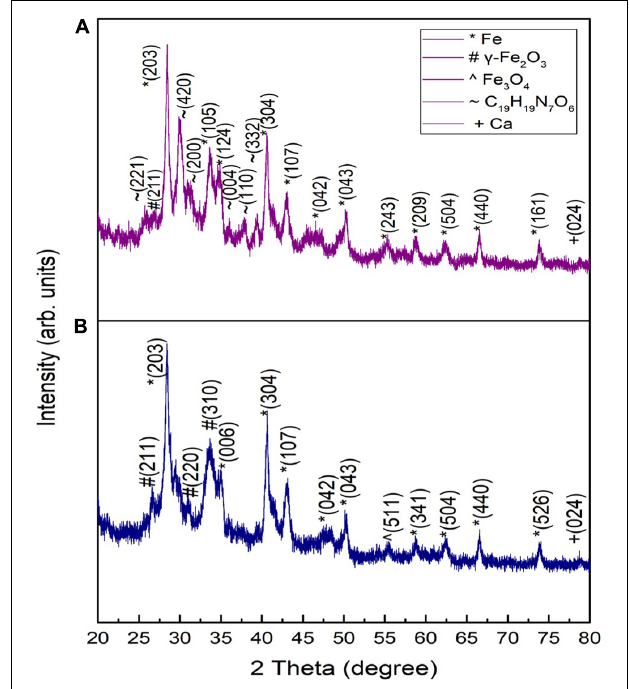
FIGURE 2 | XRD patterns of raw spinach burnt at 500 ◦ C for (A) 1 h and (B) 2 h.